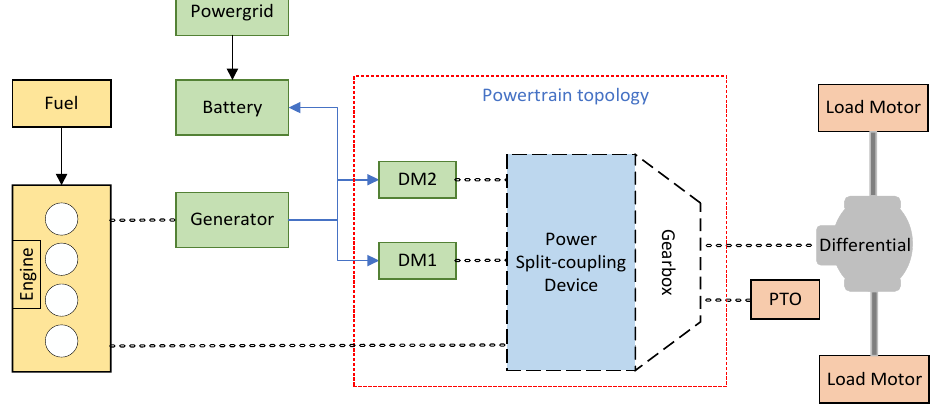
Figure 2. Schematic framework of the test platform.